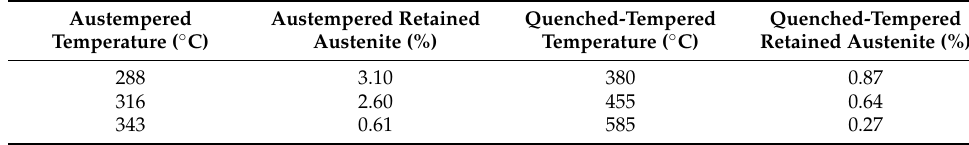
Table 3. The volume fraction of retained